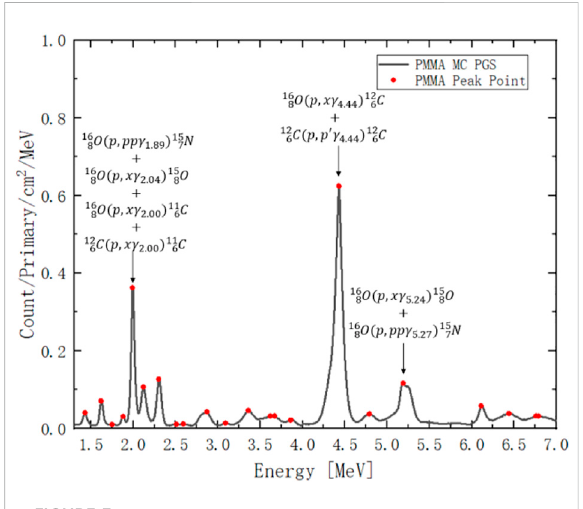
FIGURE 3 PGS spectrum from 150 MeV proton irradiation on PMMA. The red points are peak counts at a given gamma energy. The x -axis is gamma-ray energy channel from 1.3 MeV to 7 MeV. The y -axis is gamma-ray count per incident proton (primary) per unit cylinder surface area per